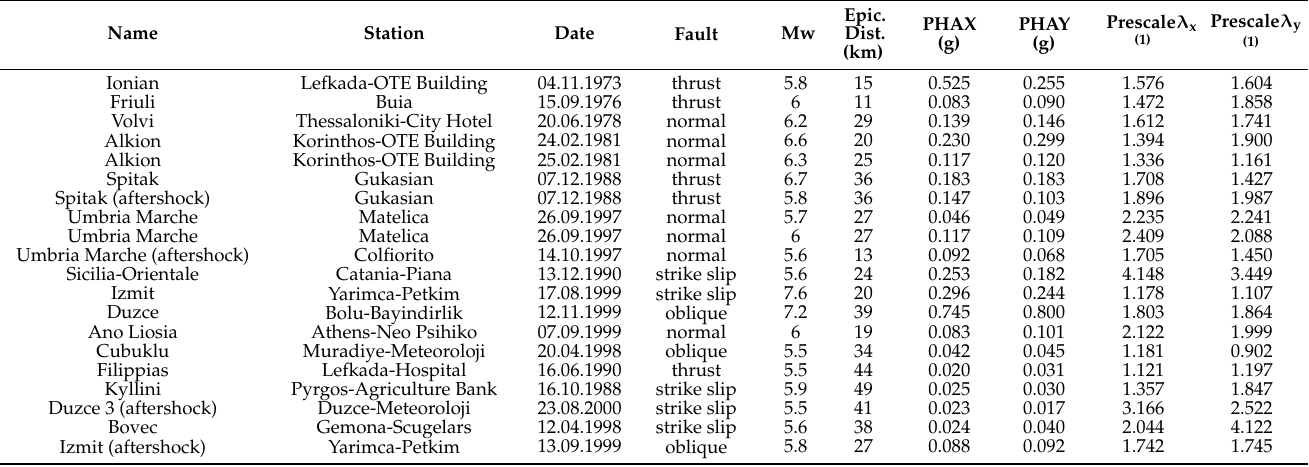
Table A3. Selection and pre-scaling of accelerograms for Ground Motion Set